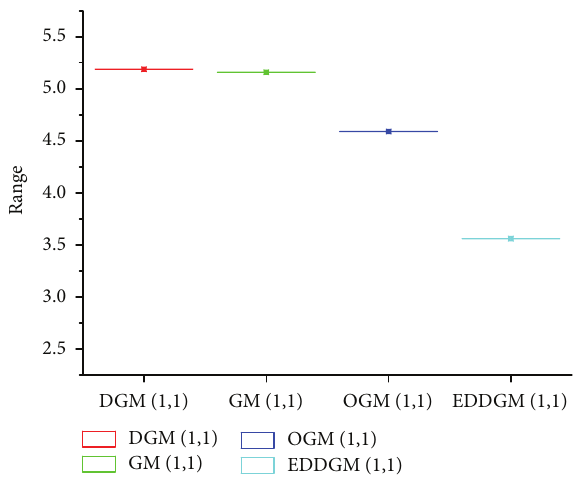
Figure 5: Average relative fitting errors of four models.